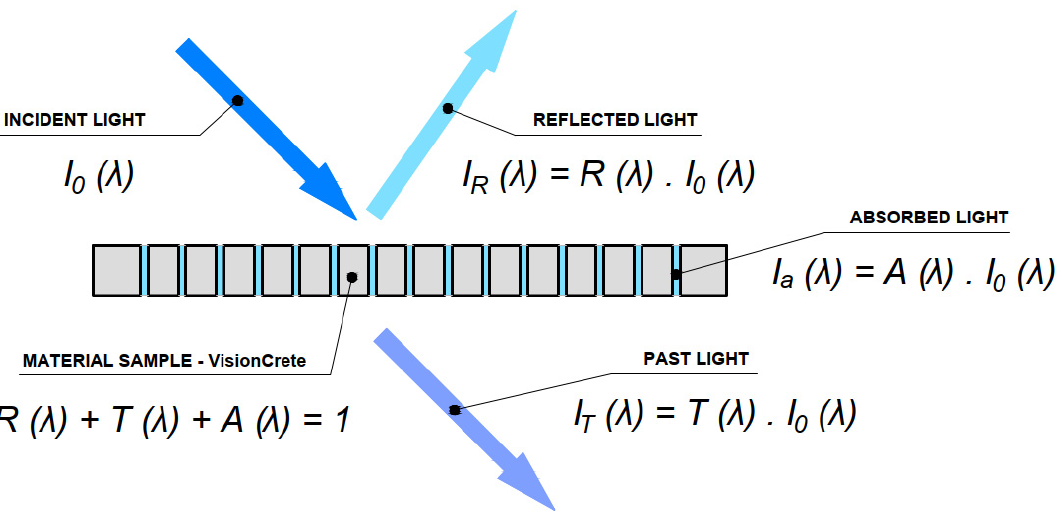
Figure 23. Diagram of the impact of the sun’s rays.